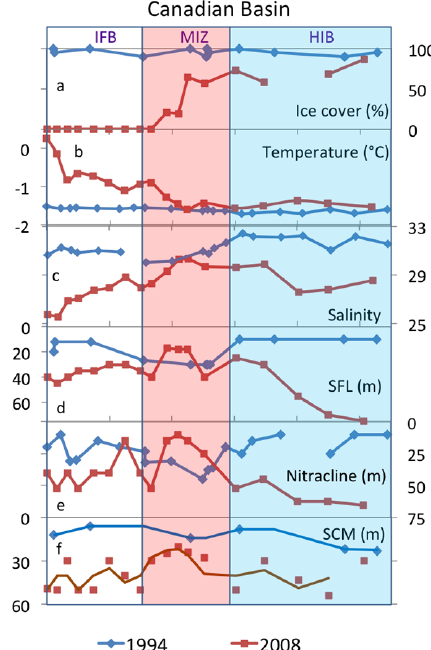
Fig. 8. Environmental parameters in surface waters and at the SCM during summer 1994 (blue bars) and 2008 (orange/brown bars) in the Canadian basin. Ice conditions labels are indicated on the top of the panels: IFB (ice-free basin), MIZ (marginal ice zone), HIB (heavy-ice basin). Ice cover in % (a) , temperature in ◦ C (b) , surface salinity (c) , SFL (surface fresh layer) depth in m (d) nitracline in m (e) SCM (sub-surface chlorophyll maximum) depth in m (f) are presented for 1994 (blue lines) and 2008 (orange